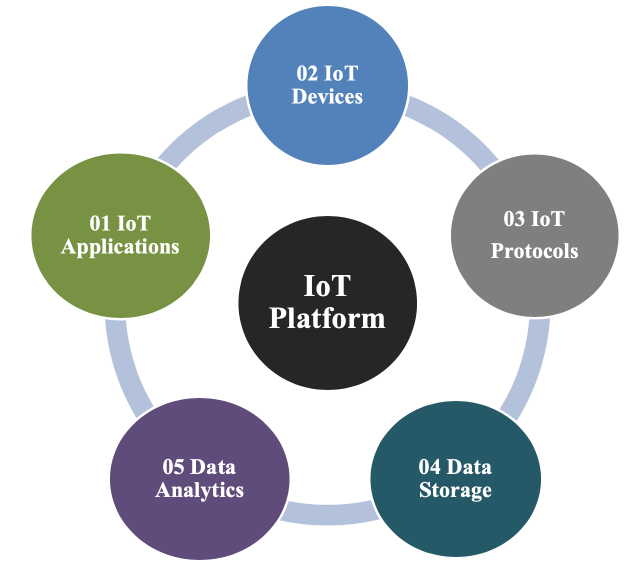
Figure 2. Diagram describing the components of an IoT